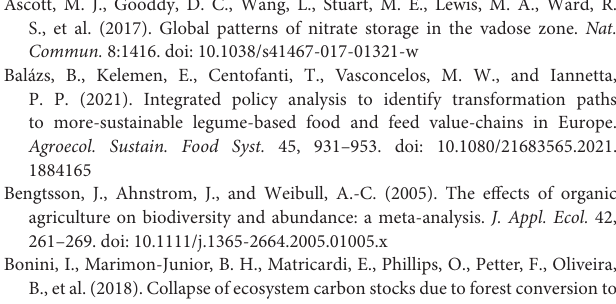
Supplementary Figure 2 | The grain- and forage-legume proportion as a fraction of the total legume proportion (grain and forage) across all the legume-supported rotations assessed by Iannetta et al. (2016), and available from the EU-funded project Legume Futures (Framework Programme) Data Repository held at